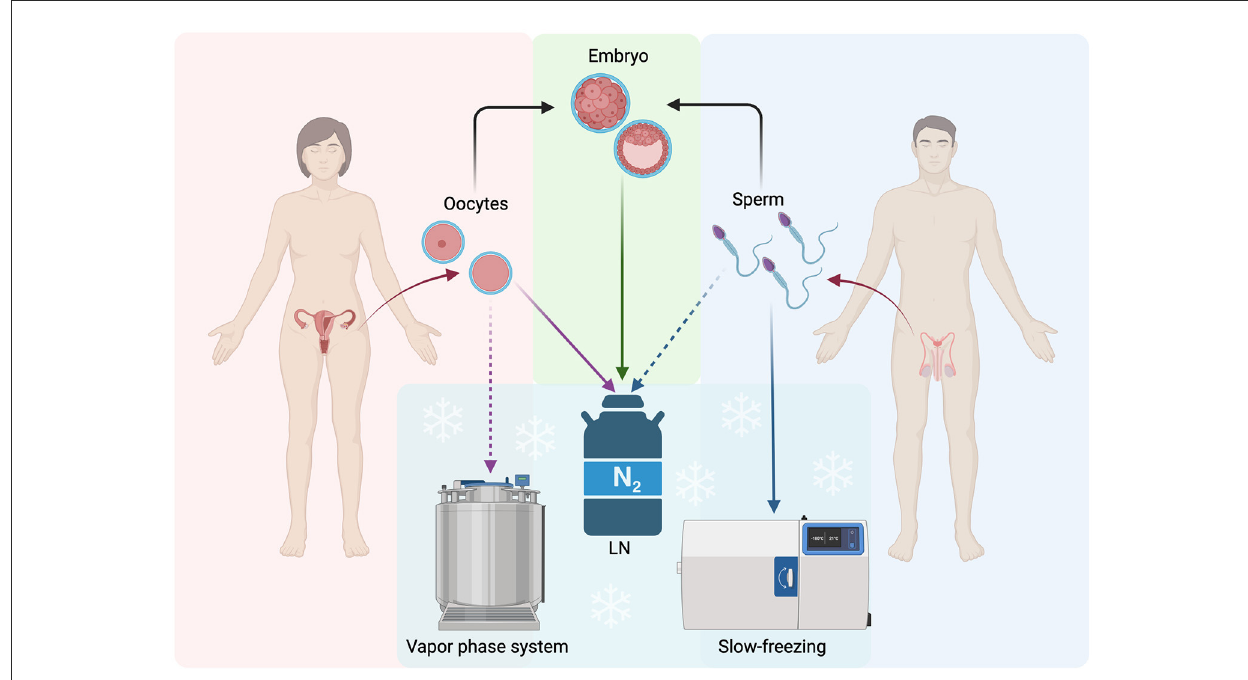
FIGURE1 Schematic representation of the main routinely applied procedures for FP: gametes and embryos. LN, Liquid Nitrogen; Solid lines, often used procedure; Dashed lines, not often used procedures. The figure was realized with BioRender.